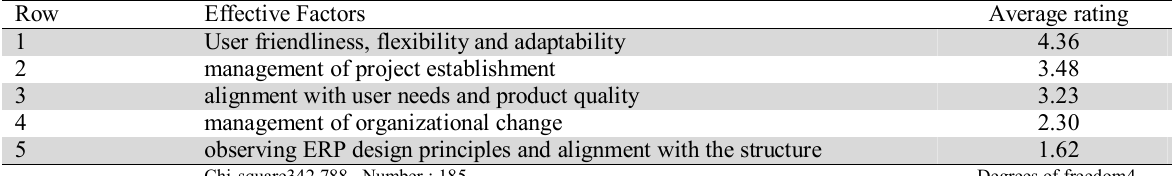
Rating importance of